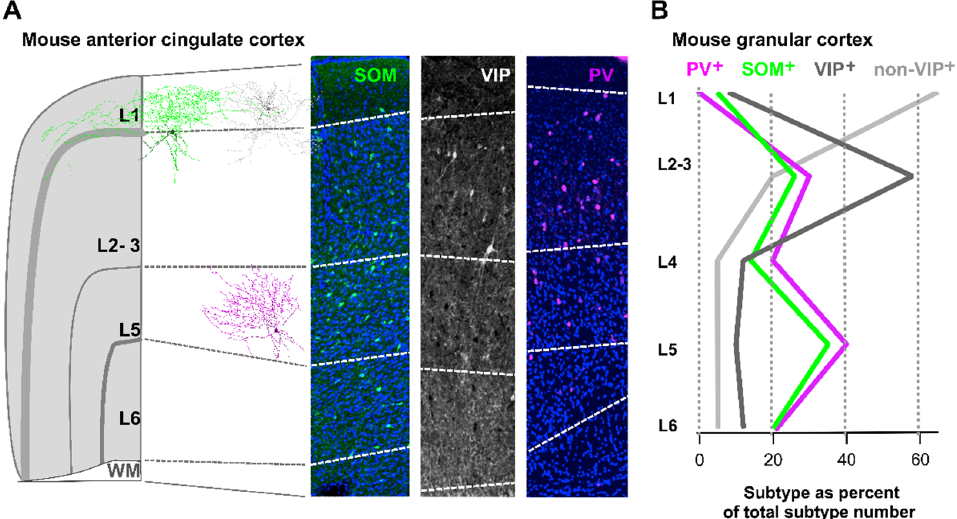
Figure 2. Laminar distribution profile of PV + , SOM + , VIP + , and non-VIP INs in the neocortex. ( A ) Left panel: schematic illustration of the mouse anterior cingulate cortex containing 1 Martinotti cell (green), 1 neurogliaform cell (grey), and 1 basket cell (magenta). Right Panel: confocal images (maximum intensity projections) of coronal sections of the mouse anterior cingulate cortex labelled for SOM + (left, green), VIP + (middle, white), and PV + (left, magenta) neurons. Nuclei were visualised with DAPI (blue) to identify cortical layers (left and right). ( B ) Diagram showing the relative fraction of PV + (magenta), SOM + (green), VIP + (dark grey), and non-VIP (light grey) INs as function of the cortical layer. PV and SOM expression can be observed in supra (L2/3) and infragranular (L5/6) layers, whereas that of VIP is restricted to supragranular layers.